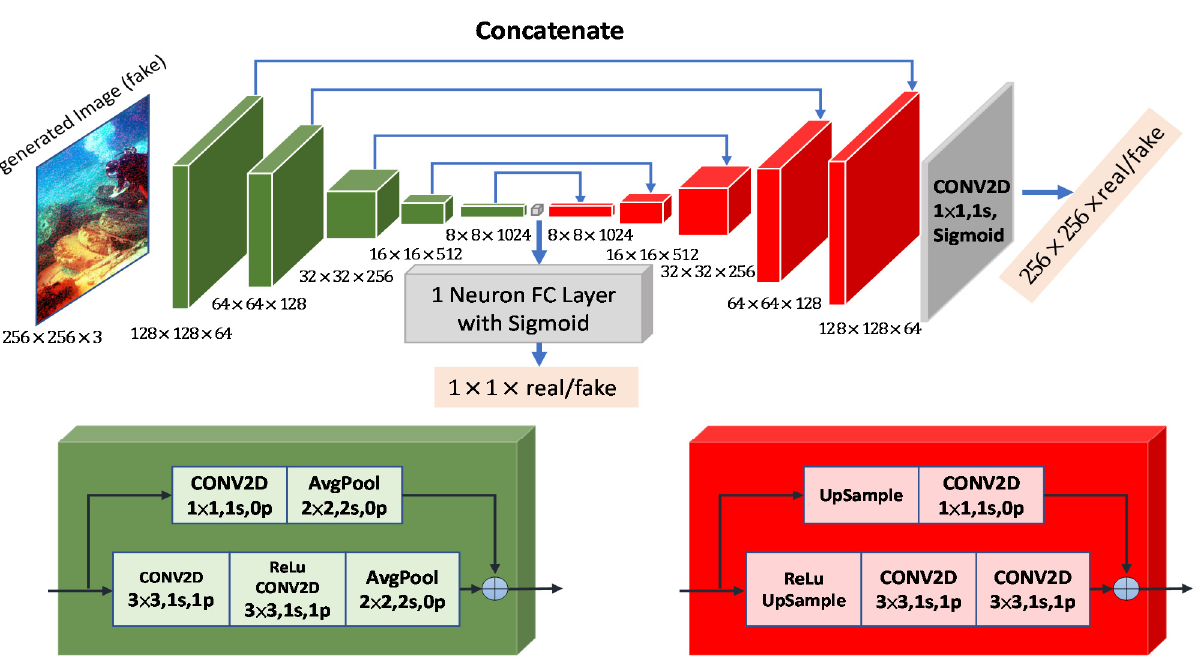
Figure 3. Proposed U-Net-based discriminator architecture. The symbol ⊕ denotes elementwise summation.